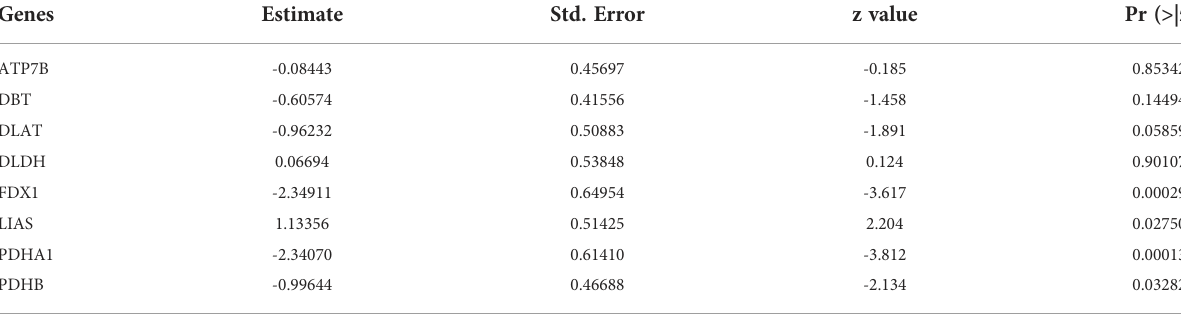
TABLE 3 Coef fi cients of the cuproptosis-related genes in modle.